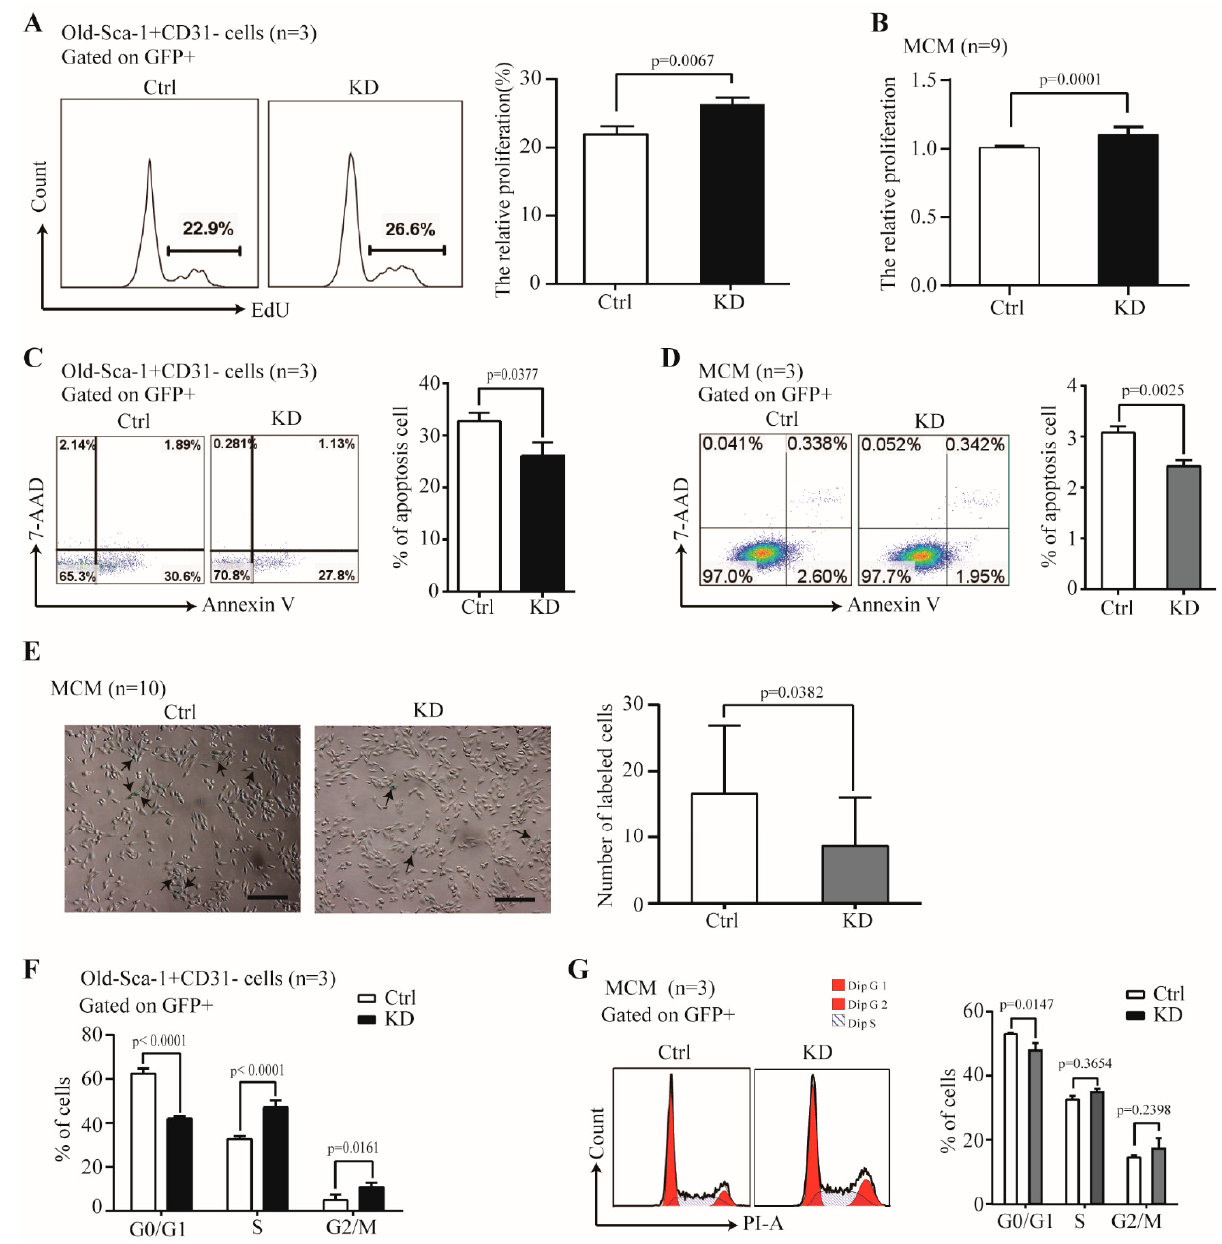
Figure 3. The effect of Nr1d1 knockdown on cell senescence. ( A ) cell proliferation of old Sca ‐ 1 + CD31 − cells transduced with a Nr1d1 ‐ shRNA lentivirus as indicated by the embedding of EdU. The flow cytometric analysis of representative Edu embedding is shown in the left panel, and the bar graph on the right panel is a statistical plot of EdU embedding. The data were from three independent experiments ( n = 3). Two ‐ tail unpaired t ‐ test was applied for statistical analysis, p < 0.05 was considered significant; ( B ) MTT analysis of cell proliferation of MCM transduced with a lentiviral Nr1d1 ‐ shRNA. The data were from three independent experiments, and each experiment had three replicates ( n = 9). A two ‐ tail unpaired t ‐ test was used for statistical analysis, and p < 0.05 was considered significant. ( C , D ) Apoptosis rate of the old Sca ‐ 1 + CD31 − cells ( C ) and MCM ( D ) transduced with lentiviral Nr1d1 ‐ shRNA analyzed by FCM with annexin V ‐ PE/7 ‐ AAD staining. The left panel is a representative flow cytometric scatter plot, and the right panel is a bar graph of apoptosis statistics. The data were from three independent experiments ( n = 3). A two ‐ tail unpaired t ‐ test was applied for statistical analysis, and p < 0.05 was considered significant; ( E ) senes ‐ cence ‐ associated beta ‐ galactosidase staining of MCM transduced with a lentiviral Nr1d1 ‐ shRNA.